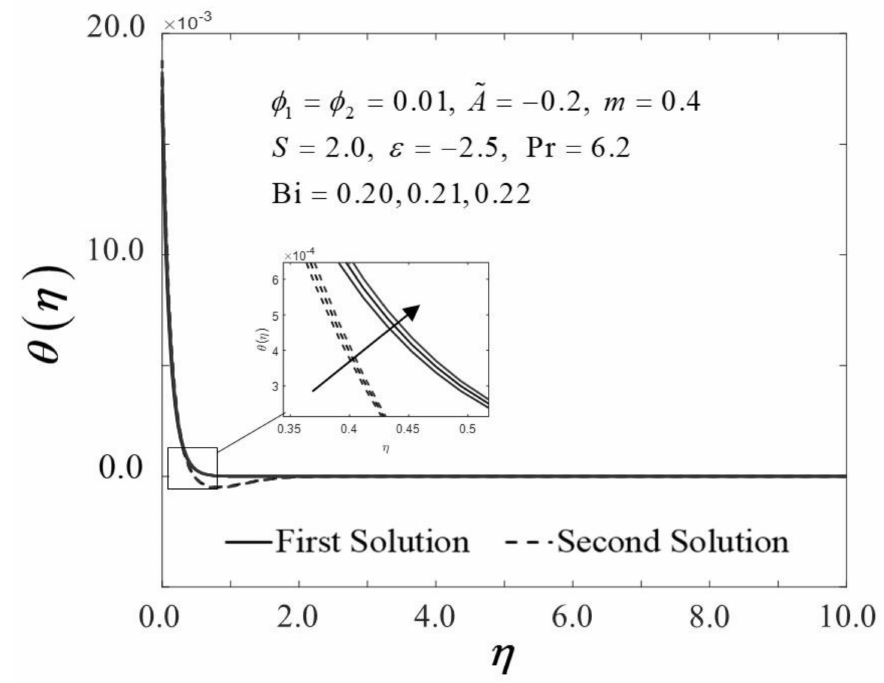
Figure 15. Trend of θ ( η ) with η and assorted